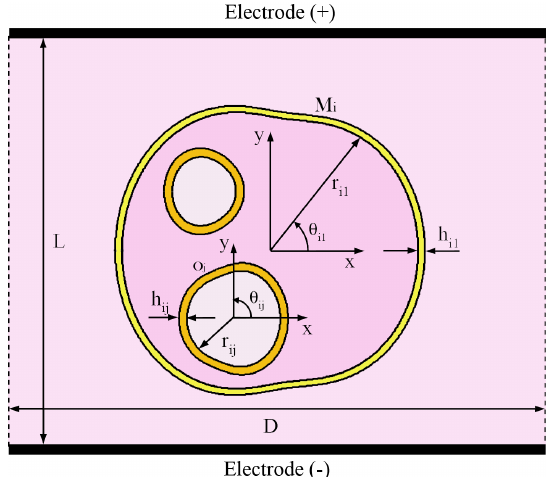
Figure 1. Schematic picture of the 2-D arbitrarily shaped cells exposed to uniform pulsed electric field. Cell geometry modeled using the Gielis’